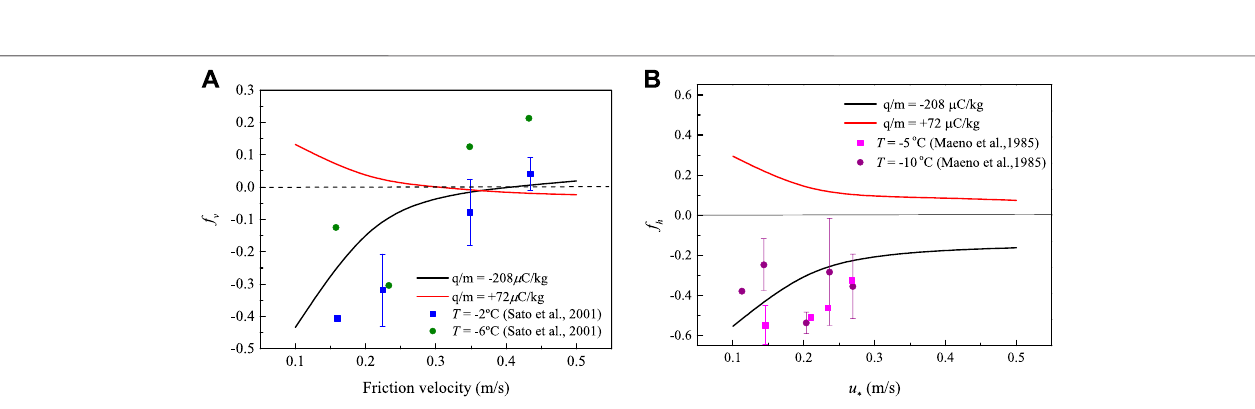
FIGURE 4 | Trajectories of aerodynamic entrainment, rebound, and ejection particles with different charge-to-mass ratios. (A) Neutral particles. (B) Negative charged particles with a mass-to-charge value of − 208 μ C/kg. (C) Positive charged particles with a mass-to-charge value of 72 μ C/kg.